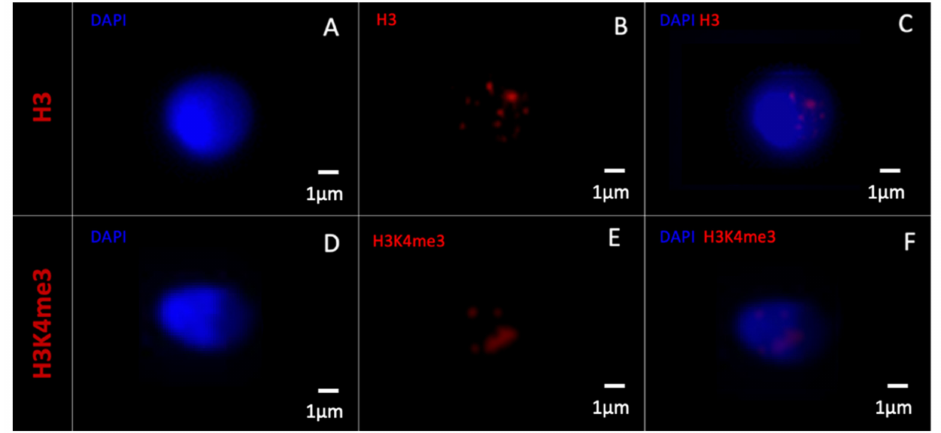
Figure 6. Morphometrically normal spermatozoa without vacuole observed with a two-dimensional fluorescence microscope. A morphometrically normal without vacuole spermatozoon ob- served with ( A ) DAPI labelling (blue), ( B ) histone 3 labelling (red, anti-H3), and ( C ) merged DAPI/H3-Cy3. Another morphometrically normal without vacuole spermatozoon observed with ( D ) DAPI labelling, ( E ) H3K4me3 labelling (anti-H3K4me3), and ( F ) merged DAPI/H3K4me3- Cy3. DAPI: 4 (cid:48) ,6-diamino-2-phenylindole, Cy3: cyanin3. Normal spermatozoa without vacuole contained a DAPI-labelled nucleus